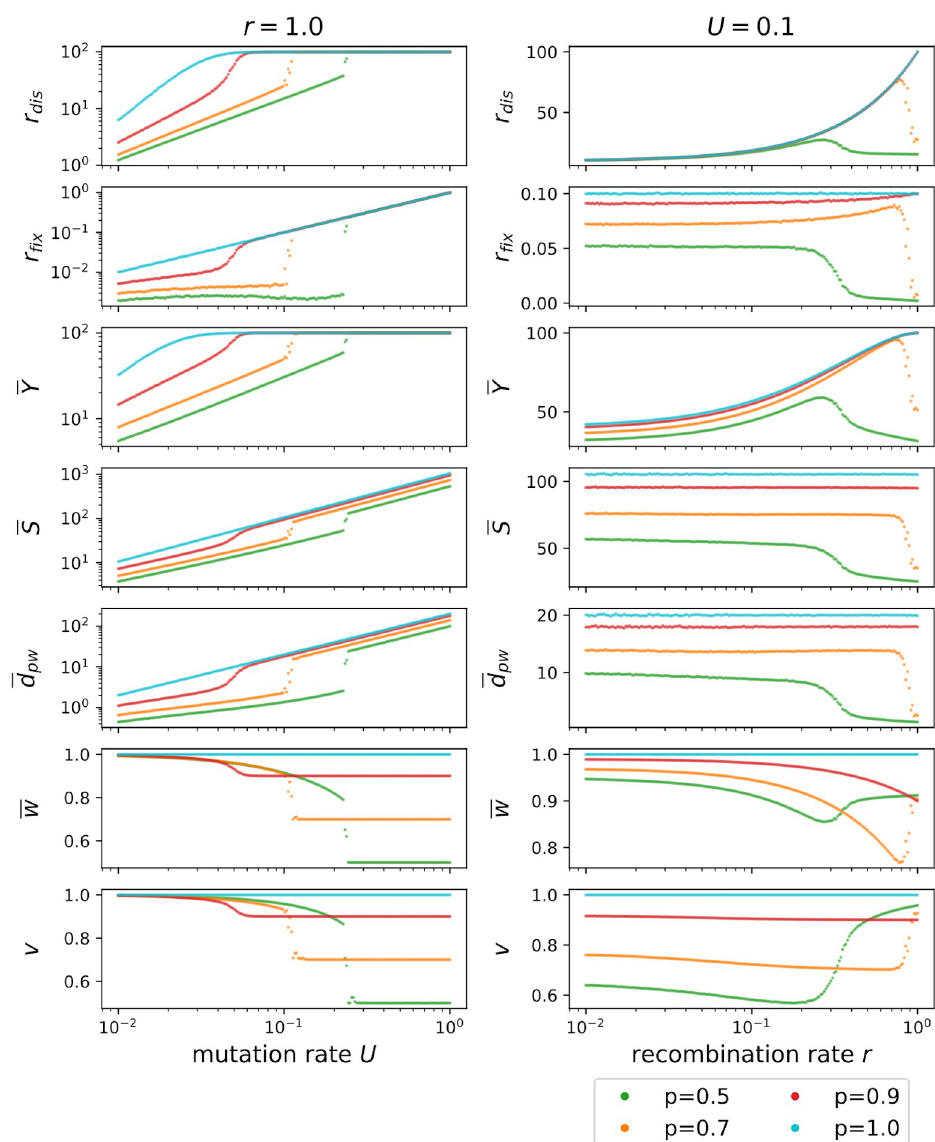
Fig 9. Various measures characterizing the ism for four different values of the fraction p of viable genotypes. The left column shows the dependence on the mutation rate U for fixed r = 1.0, and the right column shows the dependence on the recombination rate r at fixed U = 0.1. The last row shows the fraction v of viable genotypes created by recombination events. The population size is N = 100. Two supplementary figures display results corresponding to the right column of the figure at lower mutation rate U = 0.05 (S2 Fig) and with varying fitness of the unfit genotypes (S4